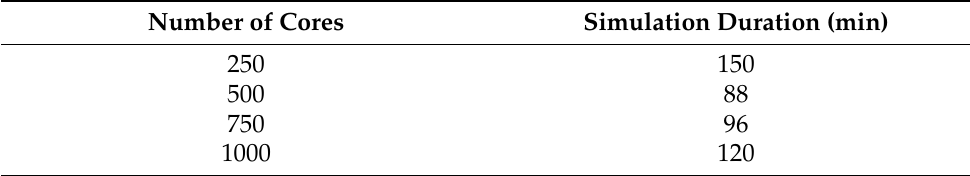
Table 3. Influence of the number of cores on the duration of the dispersion simulation.